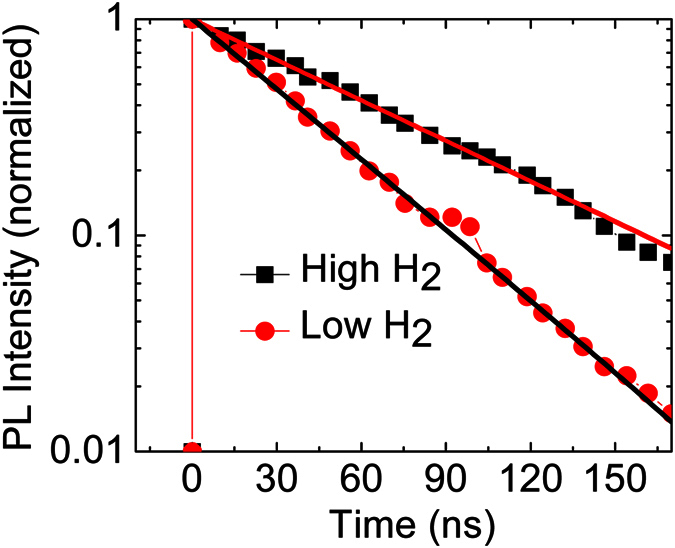
PL decay curves of TiO2/MAxFA1−xPbI3/WO3 of different H2 flow rates upon excitation at 517 nm, 90 nJ/cm2.